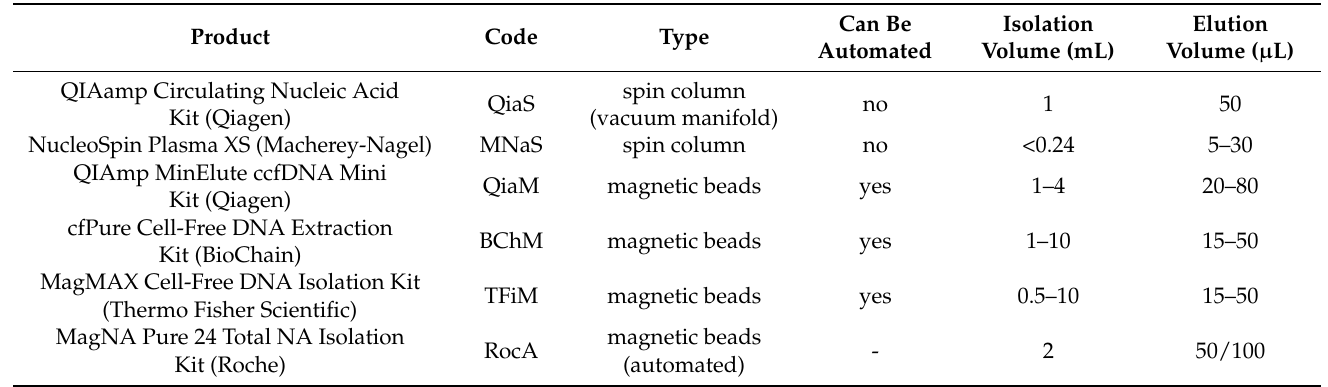
Table 1. CfDNA extraction kits compared in this